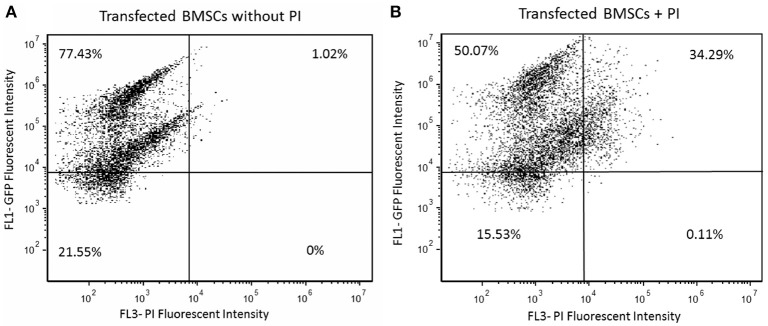
(A) Transfected HBMSCs with actin GFP were assessed for 2 days after electroporation using flow cytometry; 77.43% of the cells were shown to express high GFP intensity as seen in the first quadrant. (B) Transfected HBMSCs with actin GFP assessed for 2 days after transfection were incubated in propidium iodide (PI) solution to evaluate cellular viability; 50.07% of cells were efficiently transfected and viable after electroporation, as seen in the first quadrant.